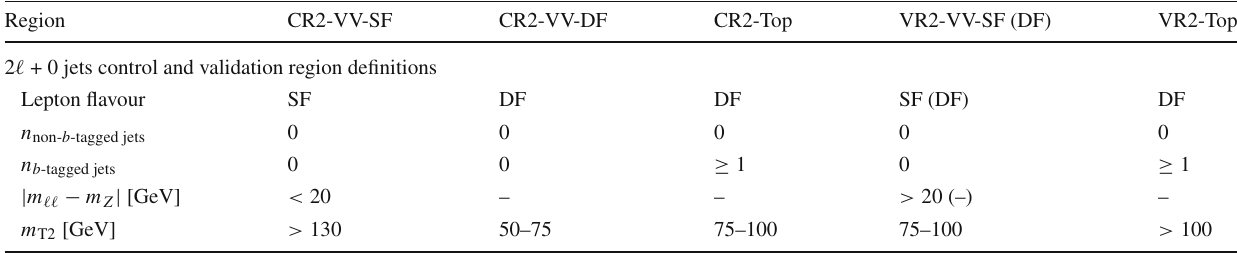
Table 5 Control region and validation region definitions for the 2 (cid:4)